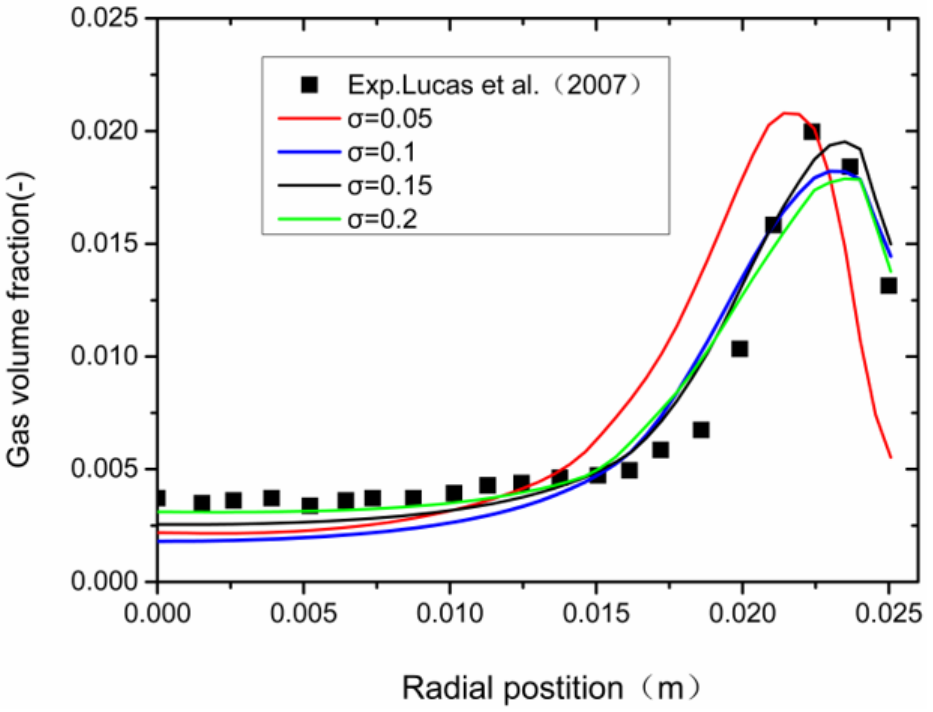
Figure 12. Distribution of gas volume fractions corresponding to different standard